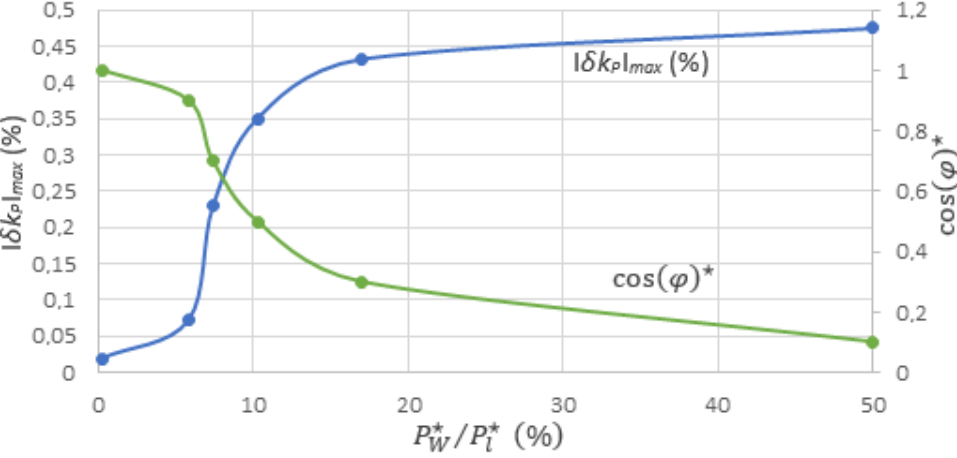
Figure 13. Dependences of the WCE on power factor on power losses to load power ratio for the WCE. Simulation results in the case of the maximum load power P max “ 2.5 p kW q and pure active load ( R ), active-inductive ( RL ) and active-capacitive ( RC ) type load are presented in Table 1. The set of selected parameters is considered as typical for the case when the reference meter is a revenue meter and the meter under adjustment is a sub-accounting meter like a smart socket in a residential